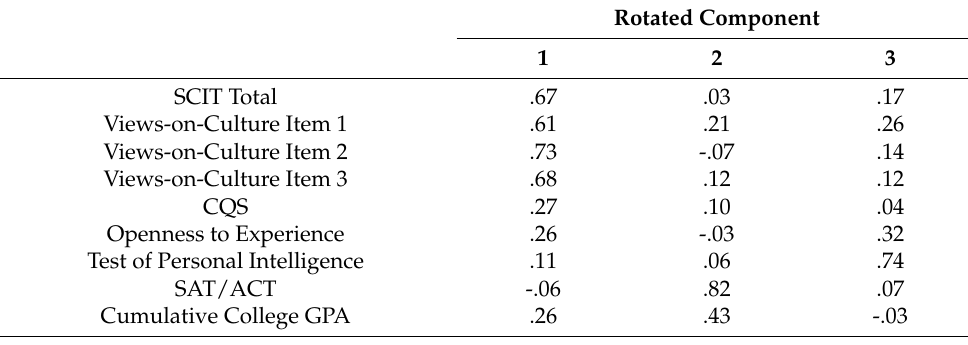
Table 10. Rotated Principal Factor Matrix: SCIT, VC, CQS, OE, TOPI, and SAT/ACT a